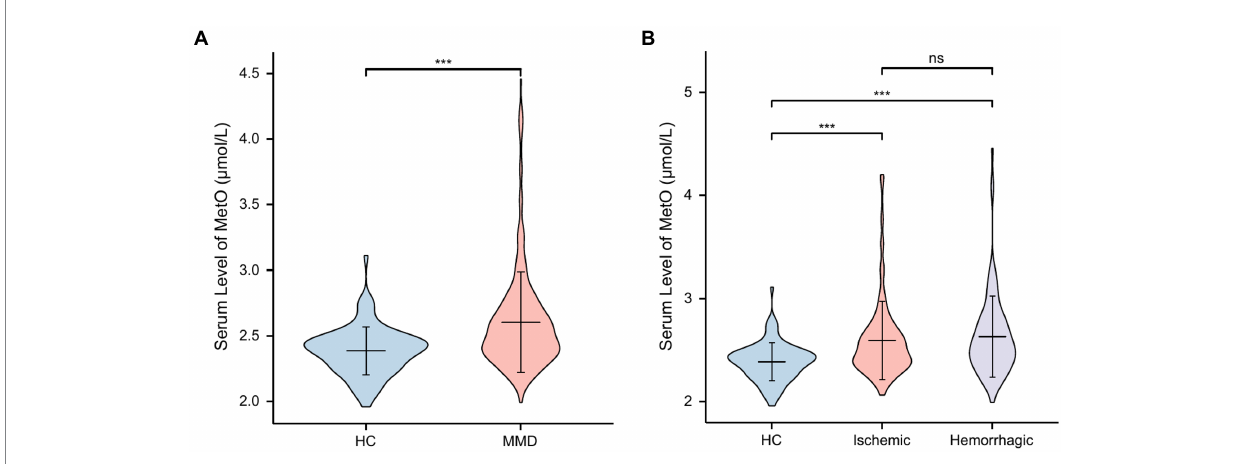
FIGURE 2 Levels of MetO between HCs and MMD and its subtypes. ns, not significant; ***, p < 0.001. (A) Comparison of MetO levels between HCs and MMD patients. (B) Comparison of MetO levels between HCs and MMD